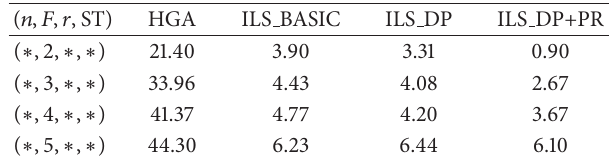
Table 5: Average RDIs (%) for instances grouped by number of jobs 𝑛 .